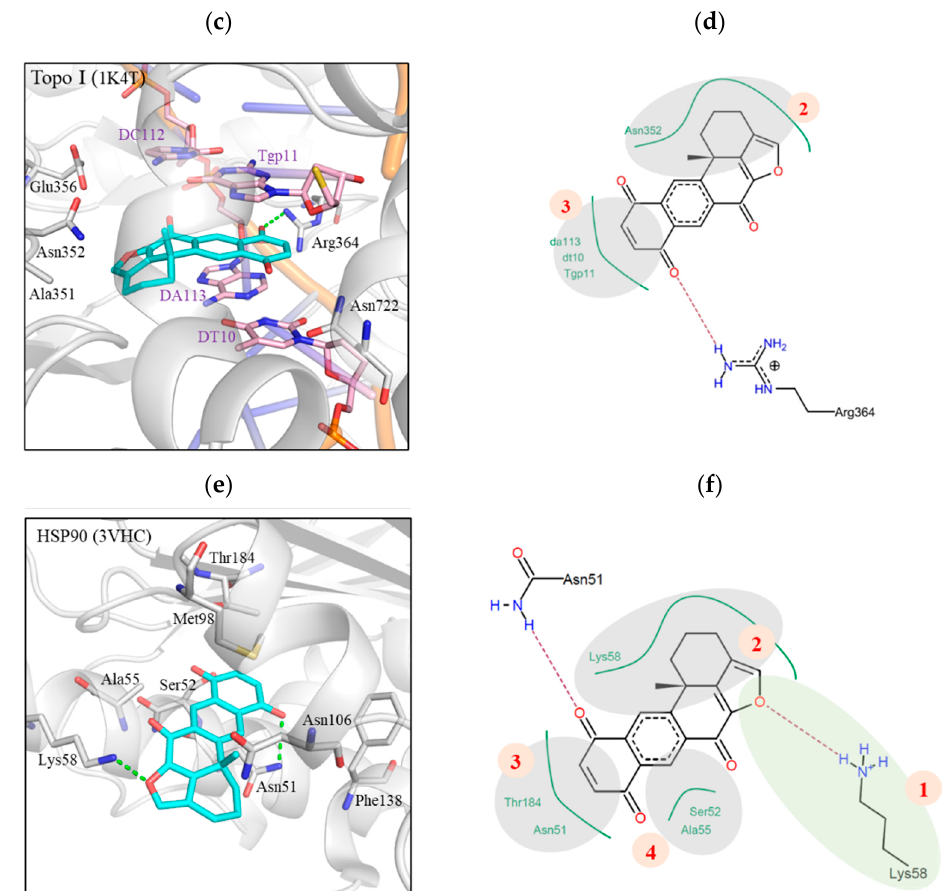
Figure 2. Docking results of XQ with Topo II, Topo I, and HSP-90 binding sites ( a ) XQ (blue) docked in Topo II (gray). ( b ) The 2D interaction map of xestoquinone in Topo II binding site. ( c ) XQ (blue) docked in Topo I (gray). ( d ) The 2D interaction map of XQ docked in Topo I. ( e ) XQ (blue) docked in the HSP-90 (gray) binding site. ( f ) A 2D interaction map between XQ and HSP-90. Hydrogen bonds in 3D figures are denoted by green lines. The 2D interaction map was generated by LeadIT. Common hydrophobic (gray) or hydrogen bonding (green) areas are highlighted. Hydrogen bonds are denoted by dashed lines. Hydrophobic interactions are 333, represented as green lines. Residues are labeled as